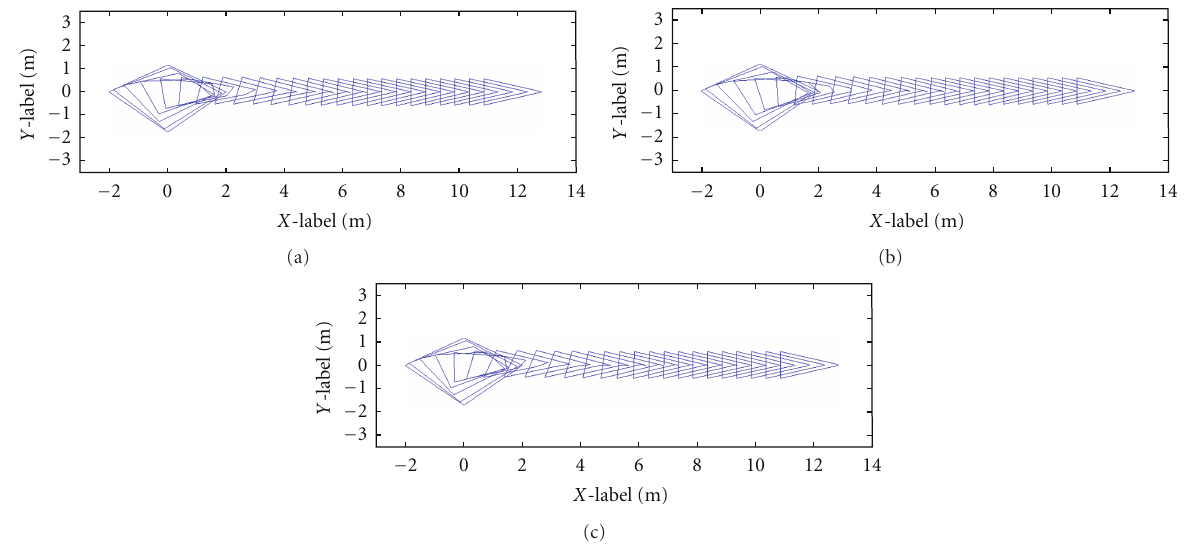
Figure 1: Evolutions of the formation with di ff erent control